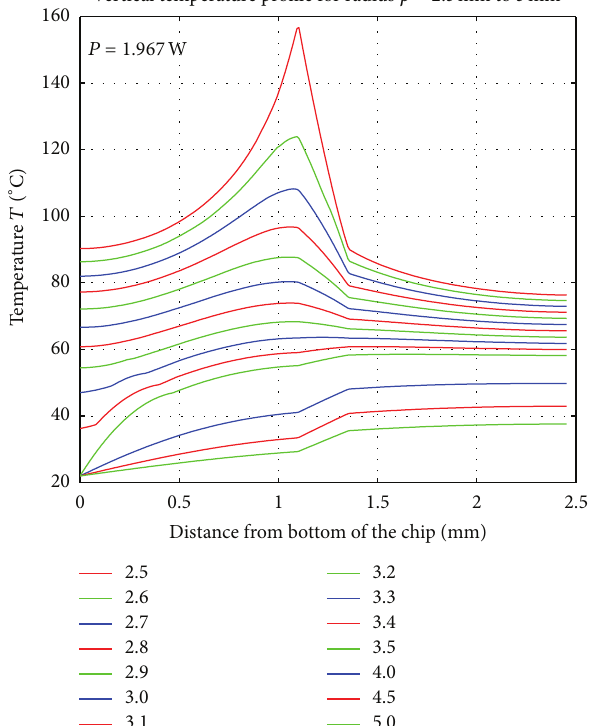
Figure 4: Steady-state vertical temperature profile predicted by FEM. Each curve shows the temperature along a vertical line that crosses through the chip. Such a line is placed at a defined distance from the centre. The legend shows the radial distance in millimetres. The horizontal axis represents the vertical distance from the bottom to the top of the chip, which is 2.454 mm thick. As the distance from the center increases from 2.5 to 5mm, the curves flattened out towards 22 ∘ C. The temperatures in the top glass plate (right side of the curves) are almost constant.